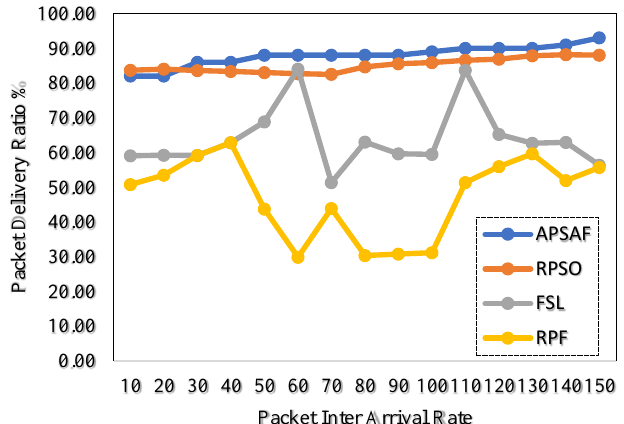
Figure 7. Packet Delivery Ratio.